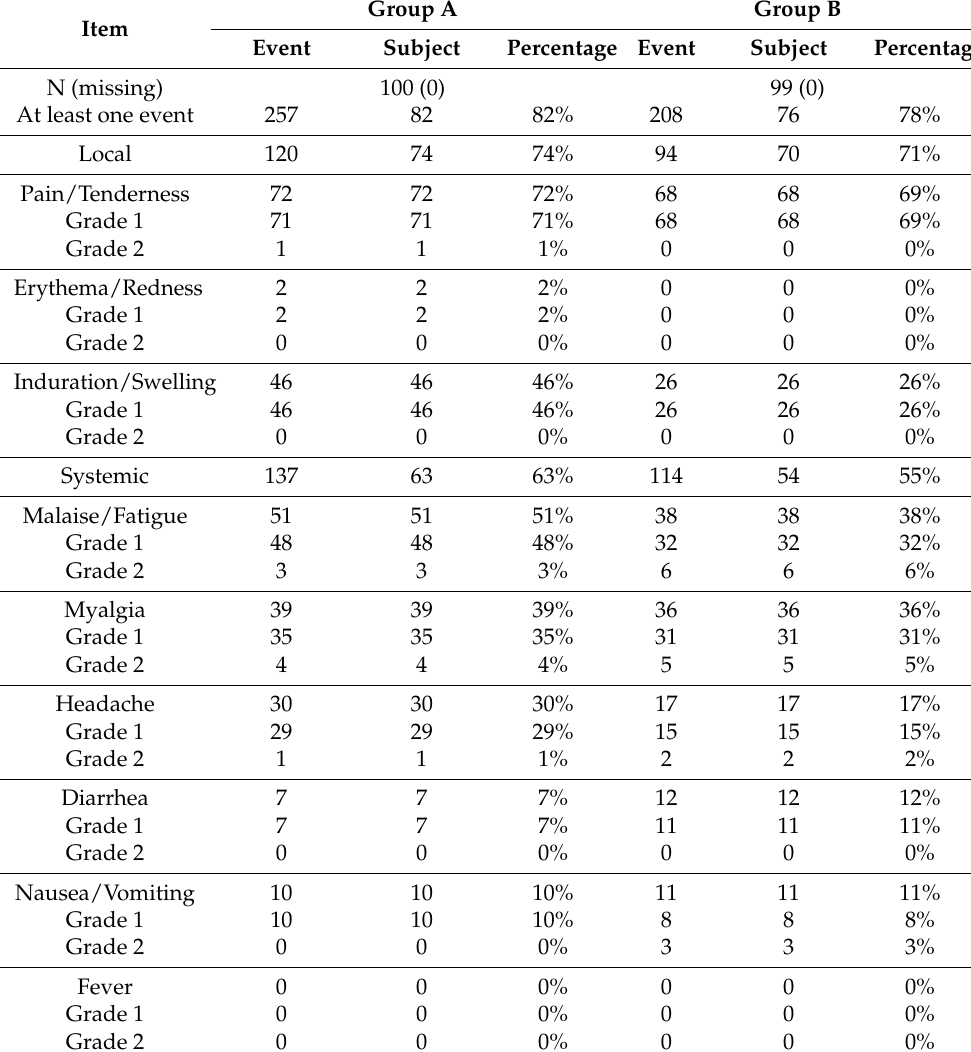
Table 2. Solicited Adverse Effects 14 days after an MVC-COV1901 booster shot.